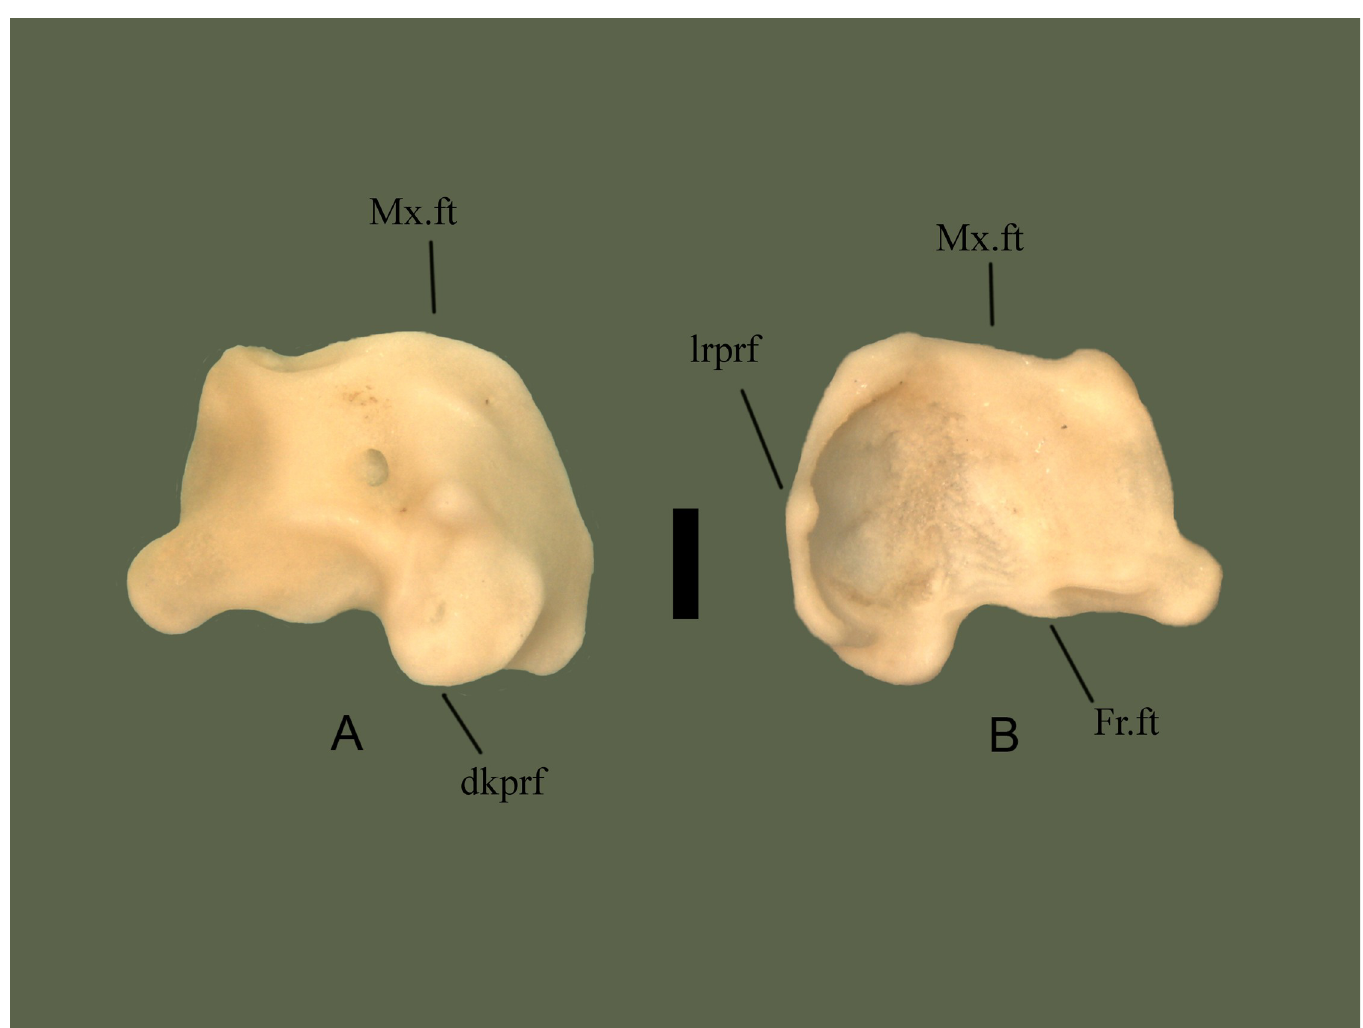
Fig 15. Right prefrontal (ETVP 3293) in dorsal (A) and ventral (B) view. Anterior is to the top. Scale bar = 1mm. Abbreviations: Mx.ft = maxillary facet; Fr.ft = frontal facet; dkprf = dorsal knob of prefrontal; lrprf = lateral ridge of